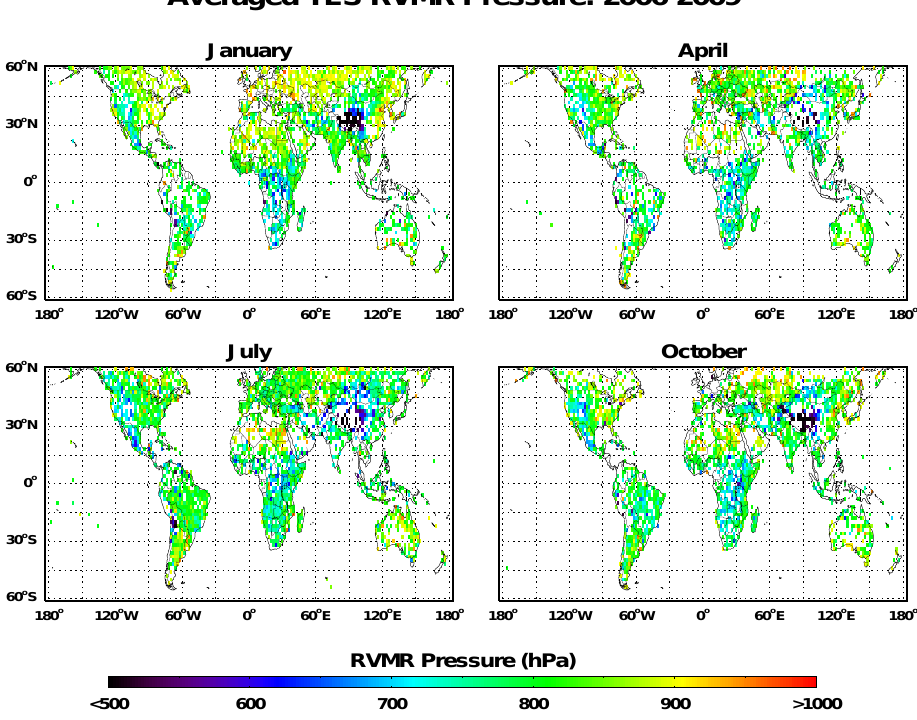
Fig. 19. TES RVMR pressure levels averaged over 2 × 2.5 ◦ boxes corresponding to the RVMR values in Fig. 11.